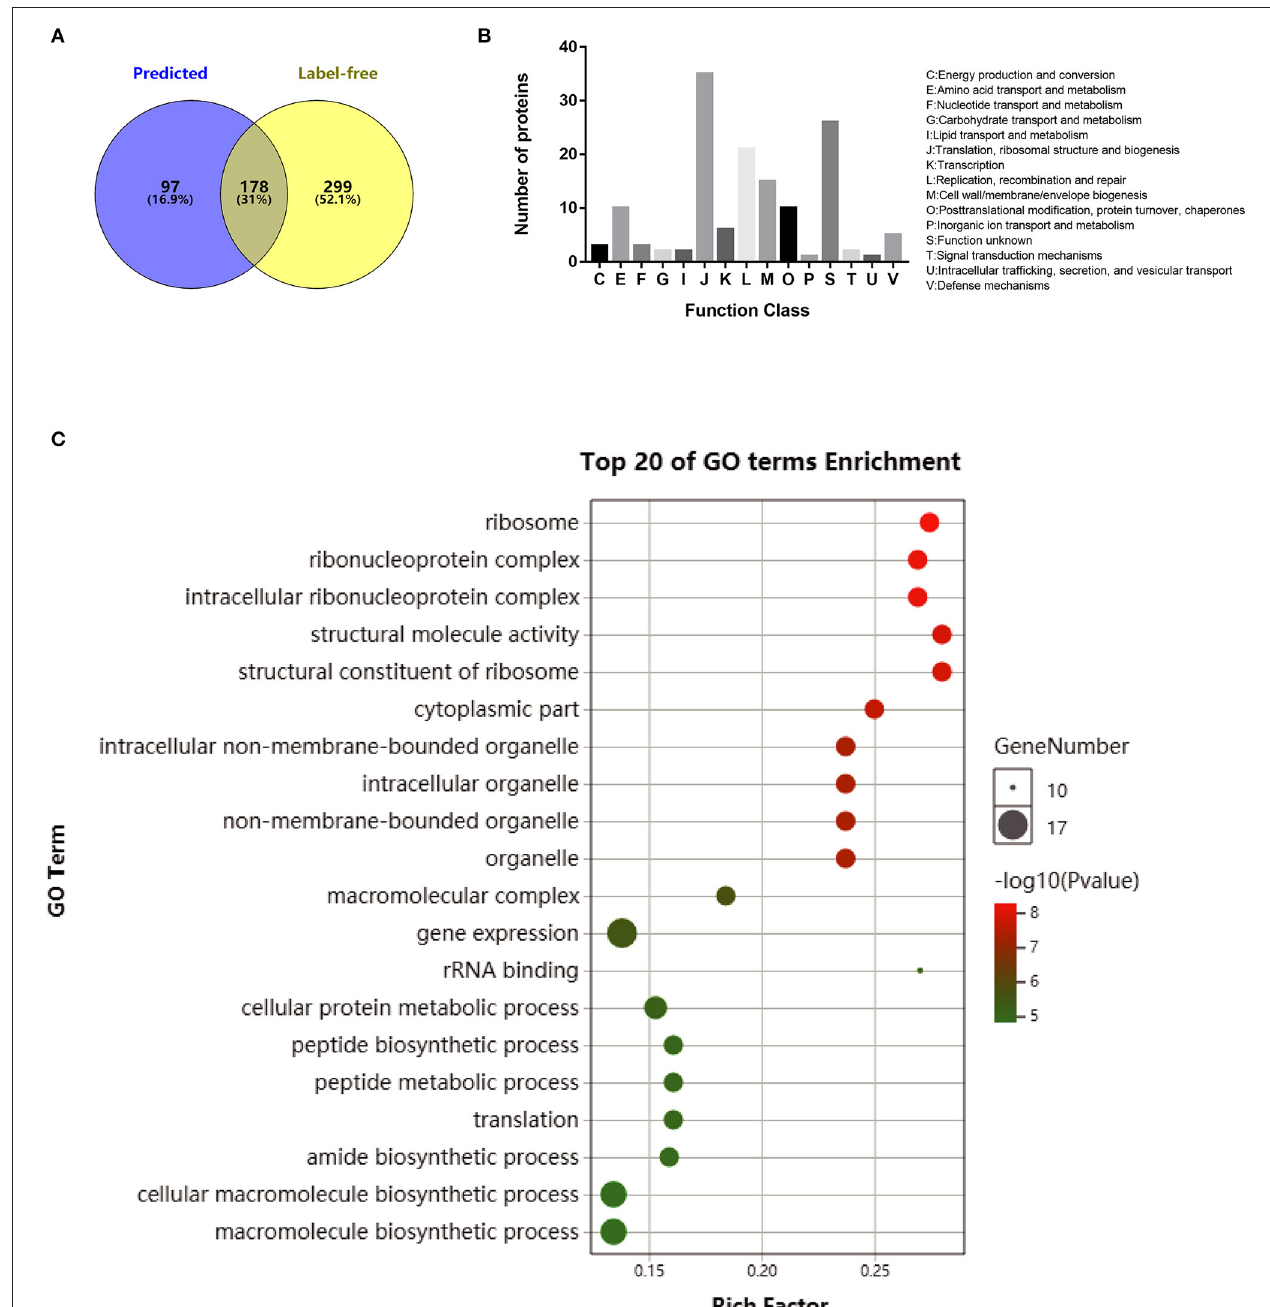
FIGURE 3 | Functional analysis of overlapped secreted proteins obtained by a computation of computational prediction and label-free proteomics assays. (A) Venn diagrams showing the proteins obtained by genome prediction and/or identified with label-free proteomic assay for both Mycoplasma bovis P1 (virulent) and P150 (attenuated) strains. (B) Protein distribution in functional categories in the cluster of orthologous groups classification. (C) Gene ontology (GO) enrichment pathway analysis of the secreted proteins in M. bovis . Only the top 20 GO enrichments are presented. The circle size is positively associated with the number of enriched genes, and the colors depict the p